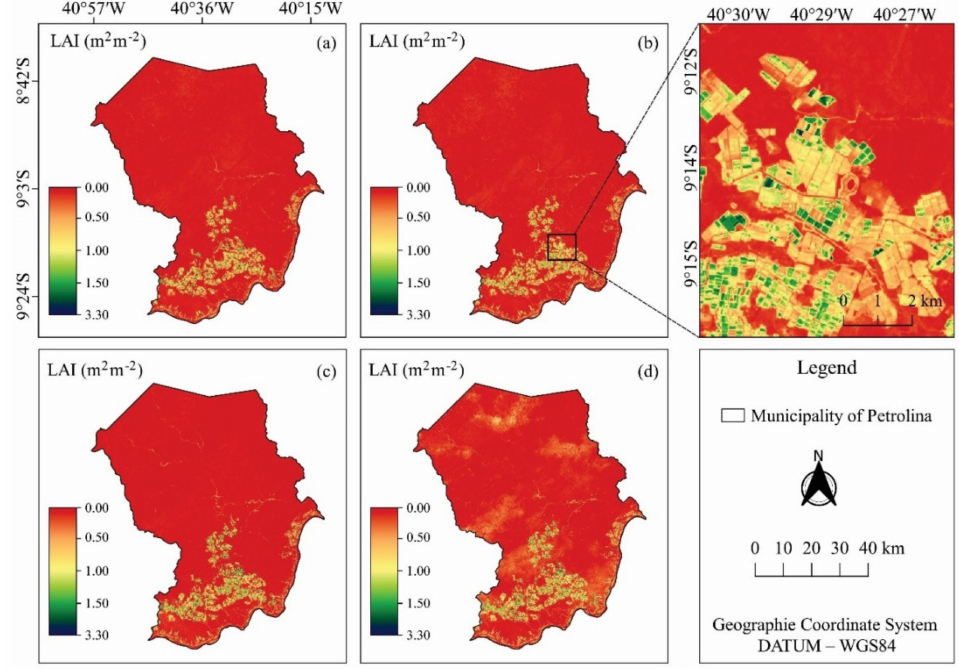
Figure 7. Spatiotemporal distribution of leaf area index (LAI, m 2 m − 2 ) in the municipality of Petrolina, Pernambuco, Brazil, on the imaging dates 5 October 2013 ( a ), 12 November 2015 ( b ), 16 October 2017 ( c ), and 7 November 2019 ( d